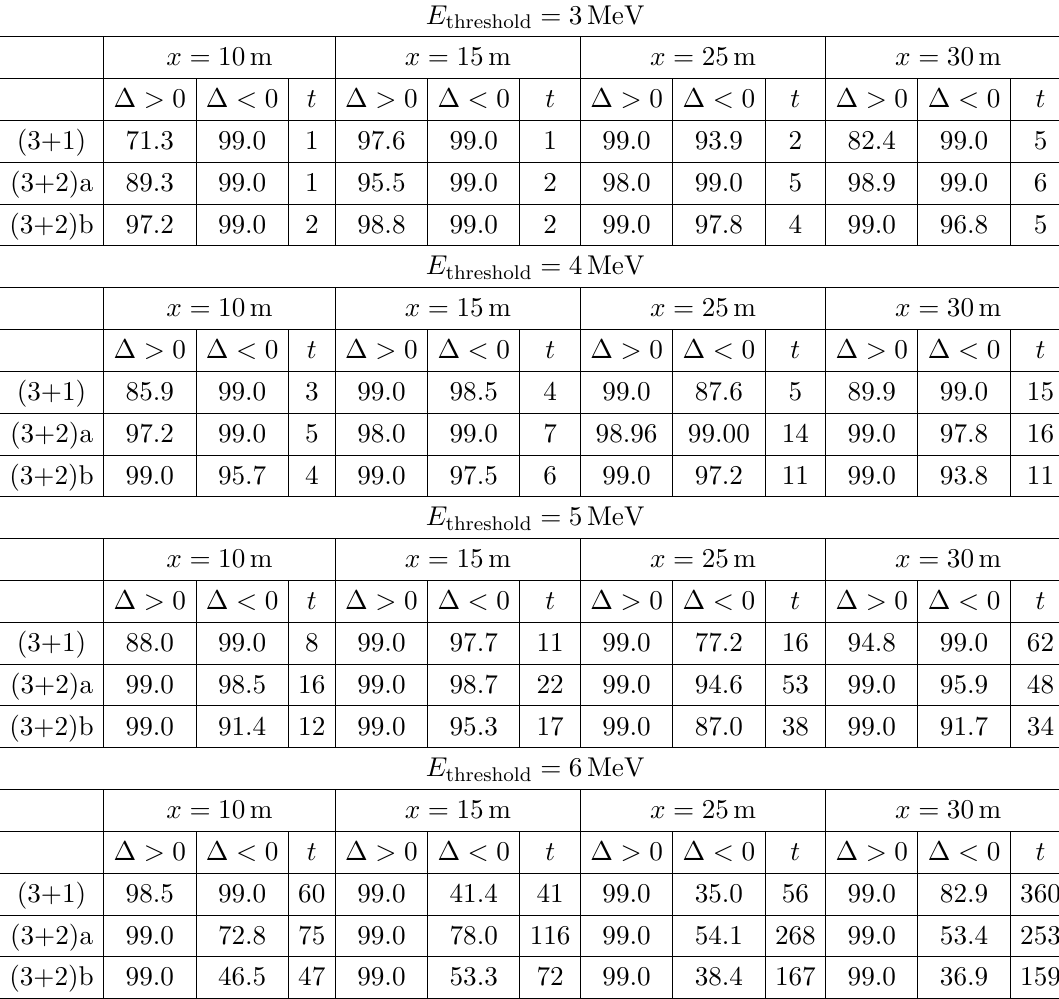
Table 2 . Con(cid:12)dence level (%) for (cid:1) p ( x ) > 0 and (cid:1) p ( x ) < 0 prediction in time t (in days) of experiment duration. The results are presented for three models [(3+1), (3+2)a and ((3+2)b]